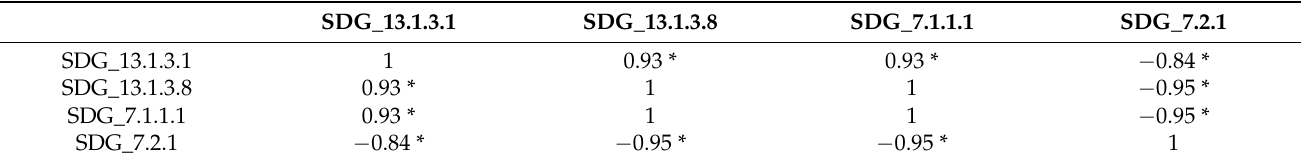
Table A5. Pairwise Pearson’s Correlation Between SDG 13 and SDG 7.